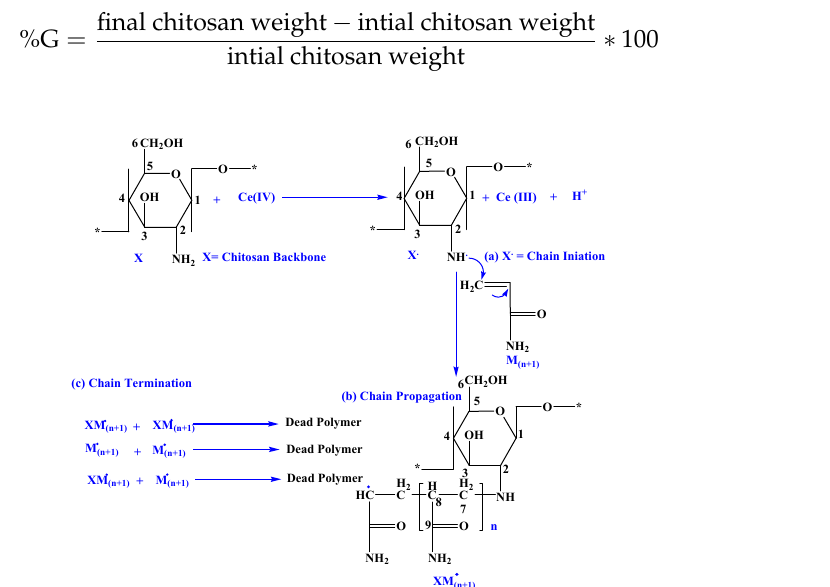
Figure 2. Mechanism of the graft copolymerization of acrylamide on chitosan backbone, where X represents chitosan and M represents acrylamide monomer.